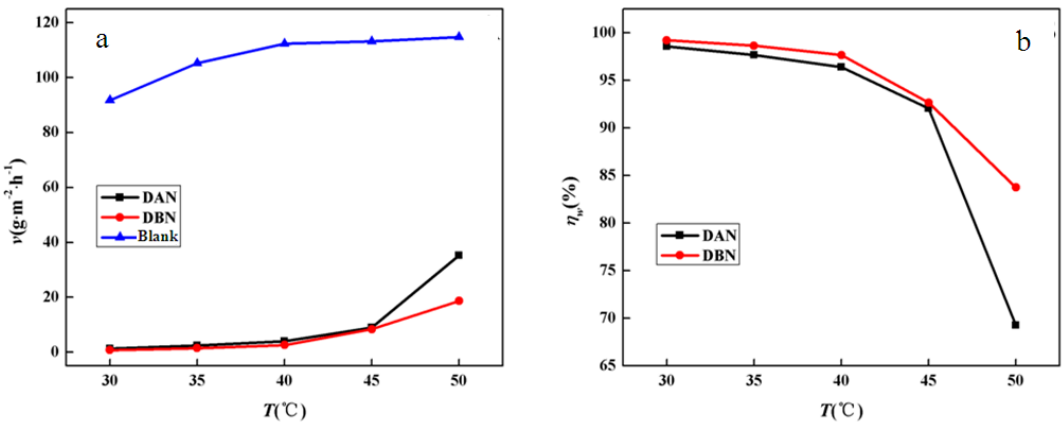
Figure 2. Variation of ( a ) corrosion rate and ( b ) inhibition efficiency of aluminum alloy in 1 M HCl with 1 mM inhibitor under different temperature (30–50 °C ).